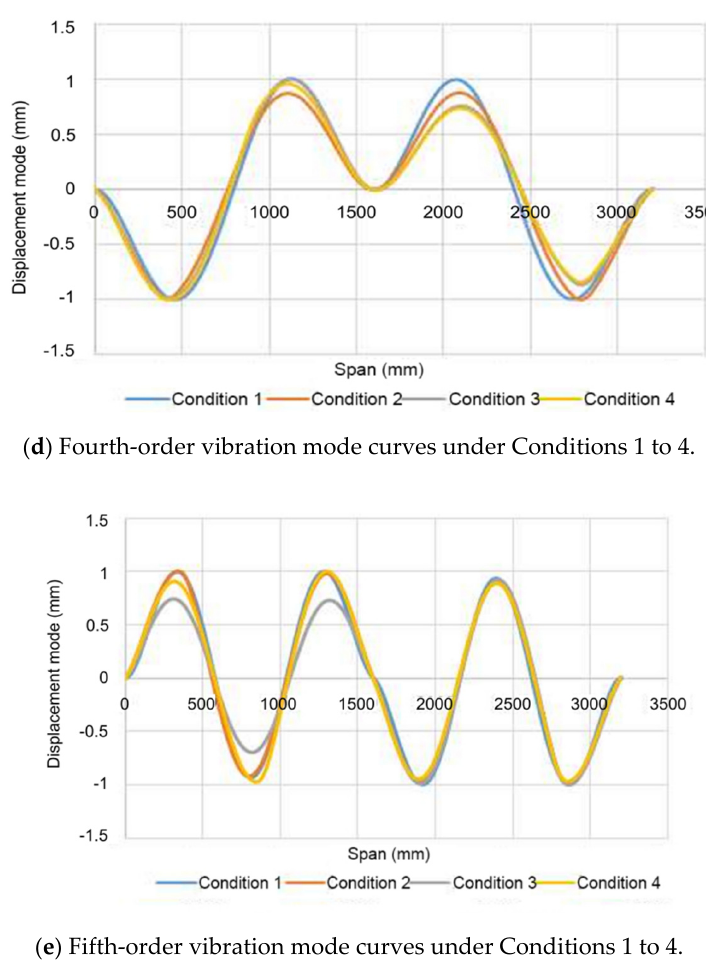
Figure 29. First five orders of vibration mode curves under Conditions 1 to 4.